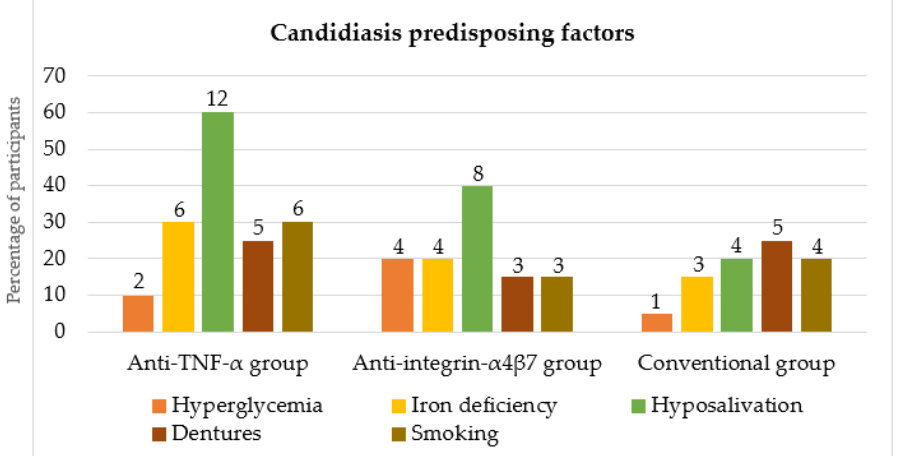
Figure 1. Predisposing factors for the development of candidiasis in the anti-TNF- α , anti-integrin- α 4 β 7 and conventional groups (numbers above columns represent numbers of participants). TNF: tumor necrosis factor.